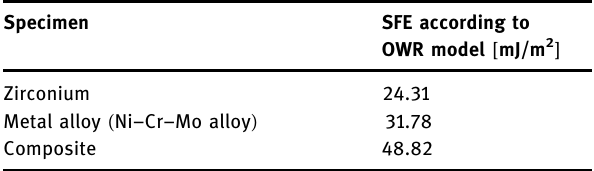
Table 3: SFE of zirconium, metal alloy and